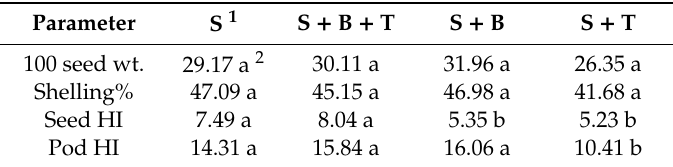
Table 4. Effect of individual and co-inoculation of peanut with Bradyrhizobium and Trichoderma on plant survival, growth, development, and yield.